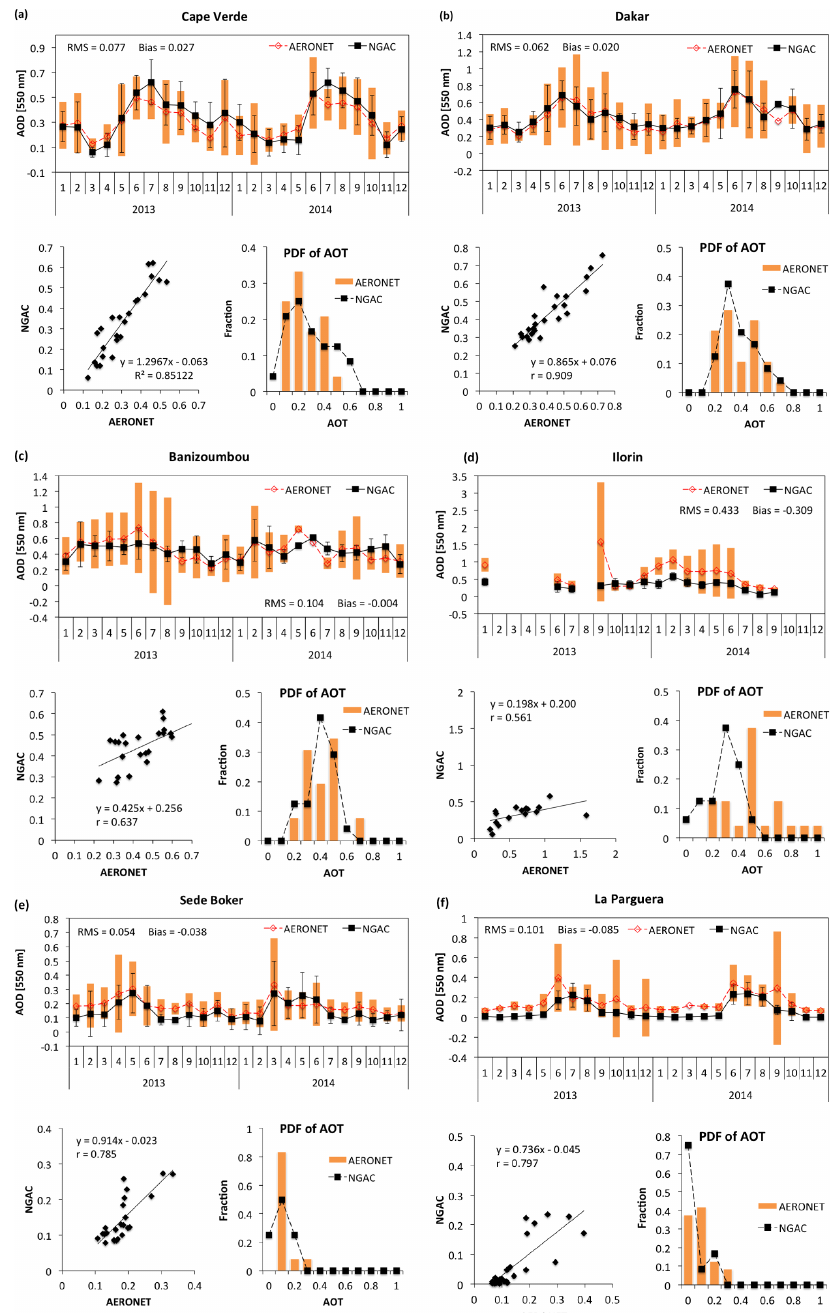
Figure 6. (a) NGAC V1.0 versus L1.5 AERONET 550nm AOD comparisons at Cape Verde for the 2013–2014 period: a time series, scatterplot, and fractional distribution histogram. In the time series, the model monthly means and standard deviation about the mean are shown in the black symbols and lines. The AERONET monthly means and standard deviation about the mean are shown in the red shading and orange bars. In the PDF plot, the model is indicated by the black symbols and line, and the AERONET observations are indicated by orange bars. (b) NGAC V1.0 versus AERONET 550nm AOD comparisons at Dakar for the 2013–2014 period: a time series, scatterplot, and fractional distribution histogram. (c) NGAC V1.0 vs. AERONET 550nm AOD comparisons at Banizoumbou for the 2013–2014 period: a time series, scatterplot, and fractional distribution histogram. (d) NGAC V1.0 vs. AERONET 550nm AOD comparisons at Ilorin for the 2013–2014 period: a time series, scatterplot, and fractional distribution histogram. (e) NGAC V1.0 vs. AERONET 550nm AOD comparisons at Sede Boker for the 2013–2014 period: a time series, scatterplot, and fractional distribution histogram. (f) NGAC V1.0 vs. AERONET 550nm AOD comparisons at La Parguera for the 2013–2014 period: a time series, scatterplot, and fractional distribution